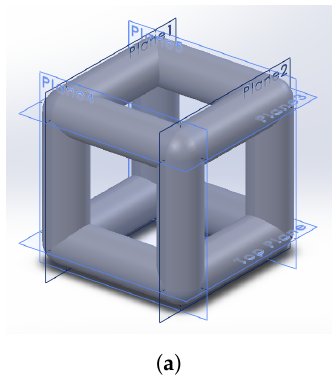
Figure 8. ( a ) Untrimmed cell; ( b ) trimmed